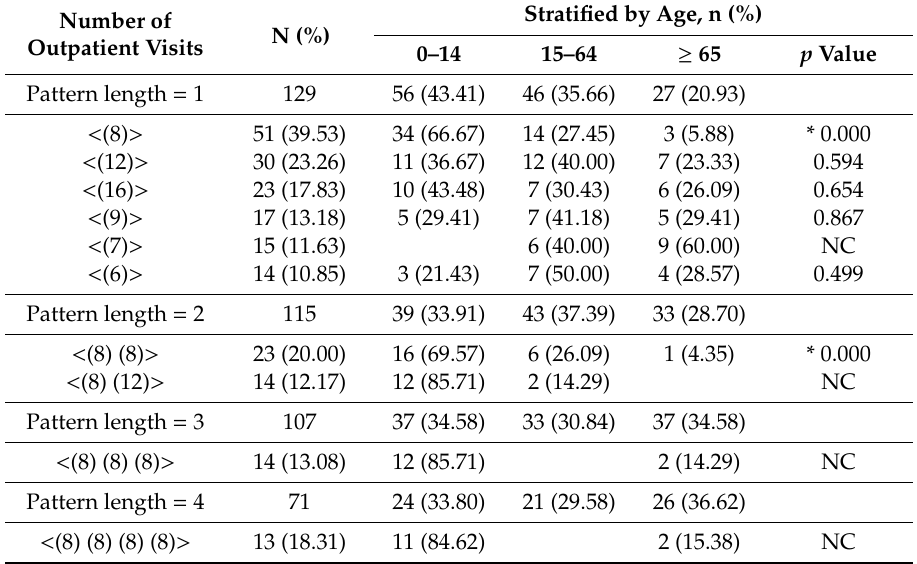
Table 7. The mined sequential patterns of diseases contracted before the development of